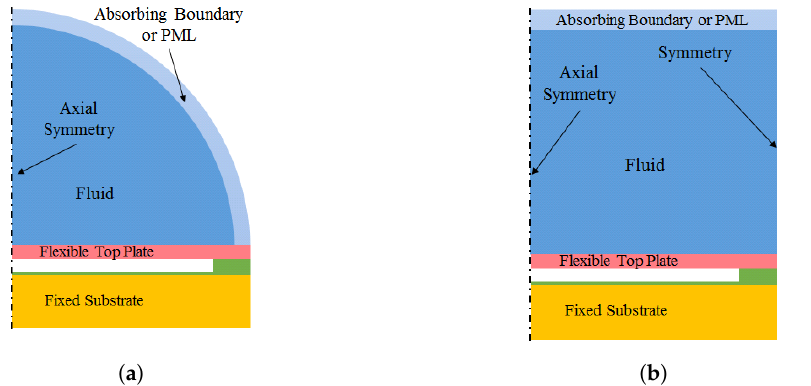
Figure 4. Geometry and boundary conditions of 2D-Axisym. CMUT finite element (FE) models. ( a ) Single